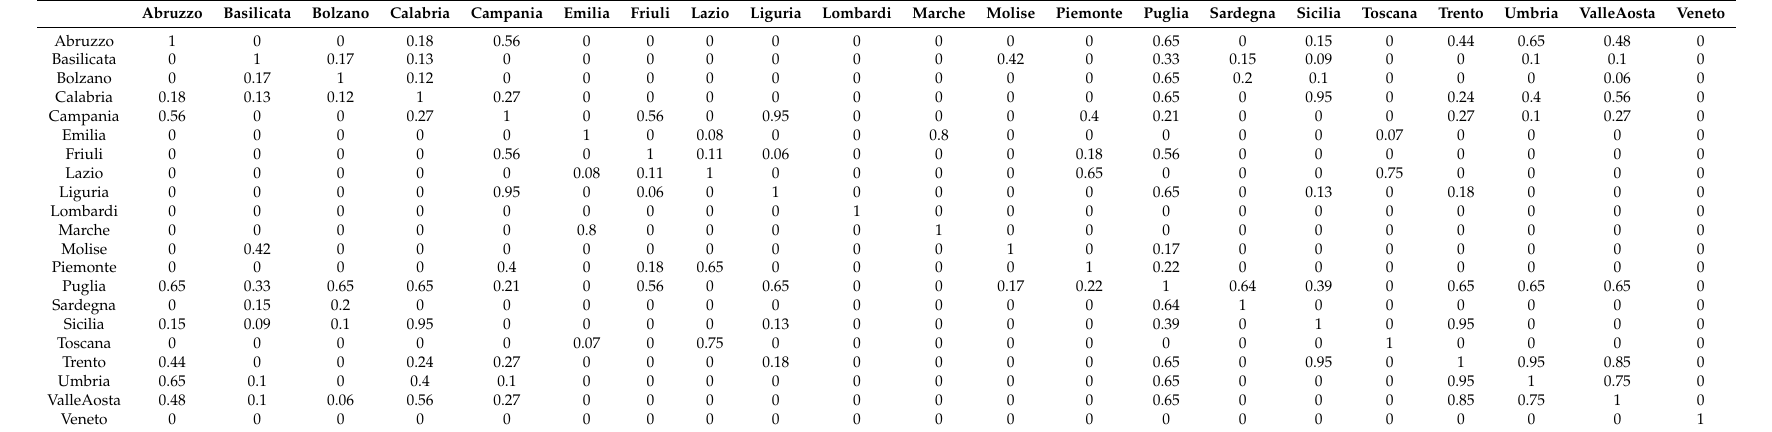
Table A56. Similarity values of Swabs network in the first